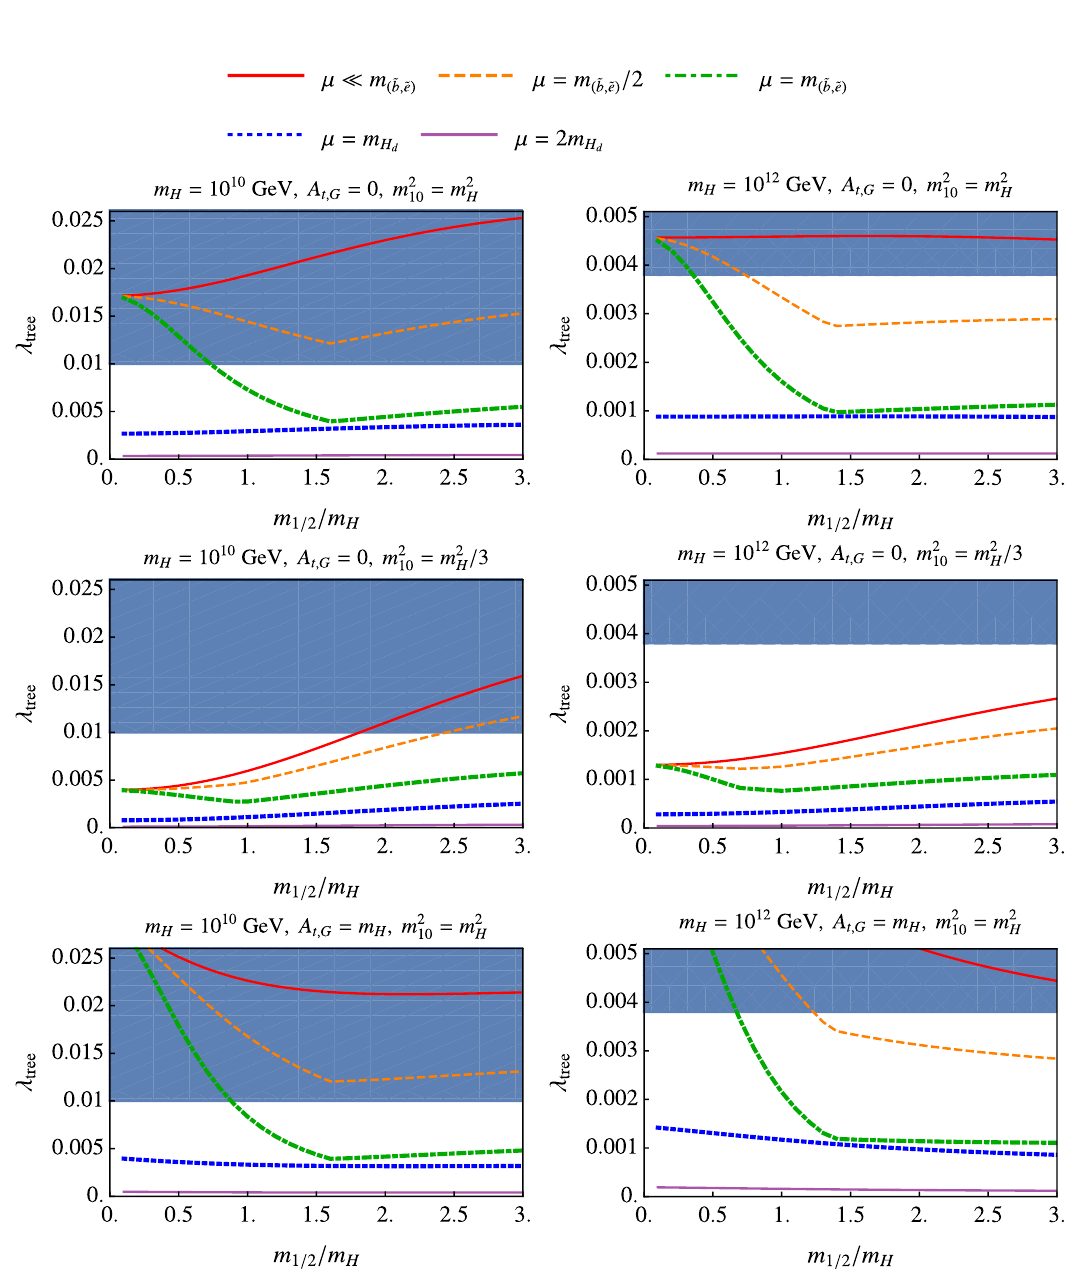
Figure 8 . Prediction for the tree-level quartic coupling with a UV boundary condition m H In the blue shaded region, reproducing λ ( m − ) requires m t < 171 . 86 GeV, 3 σ away from the central value. Here we impose α s ( m Z ) < 0 . 1189 and δλ ( m − ) > − 0 . 002